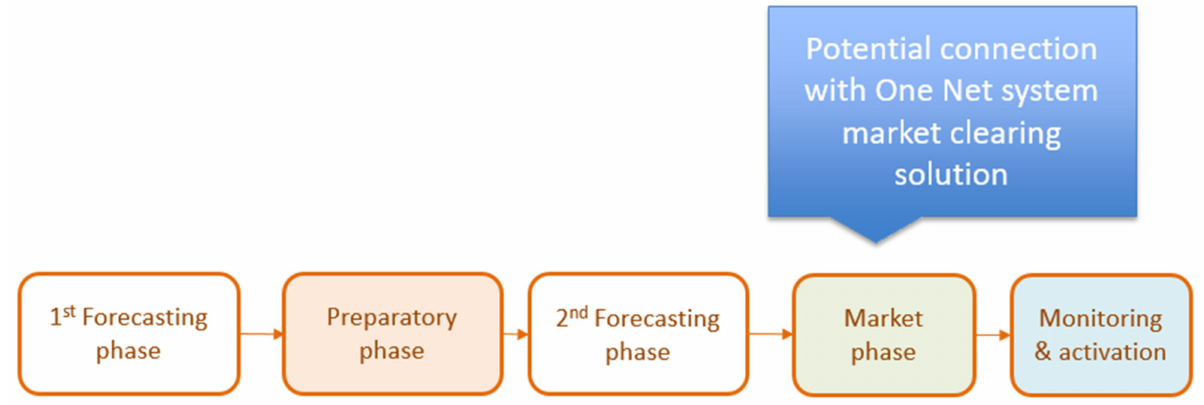
Figure 13. Domains have been identified to be integrated with F-channel.